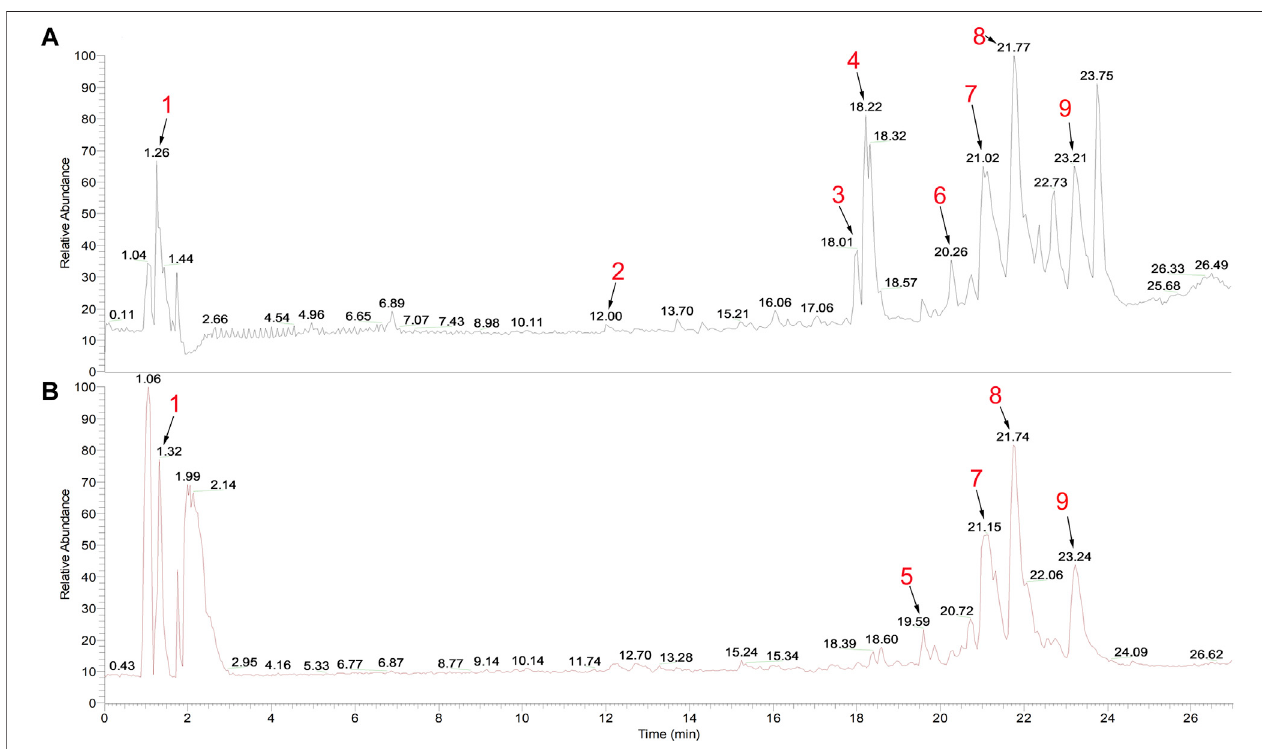
FIGURE 1 | Total ion chromatogram of SBP-containing serum in (A) positive and (B) negative modes. Peak 1: N1-(1,3,5-Trimethyl-1H-pyrazol-4-yl)-2-cyano-3- (dimethylamino) acrylamide; 2: isoliquiritigenin; 3: 2-Methoxyestrone; 4: 6-O-Pentopyranosyl-1-O-[(2,6,6-trimethyl-1-cyclohexen-1-yl)carbonyl]- β - D -glucopyranose; 5: oleanolic acid; 6: monoolein; 7: 18- β -Glycyrrhetinic acid; 8: 9(Z),11 (E) -Conjugated linoleic acid; and 9: oleic